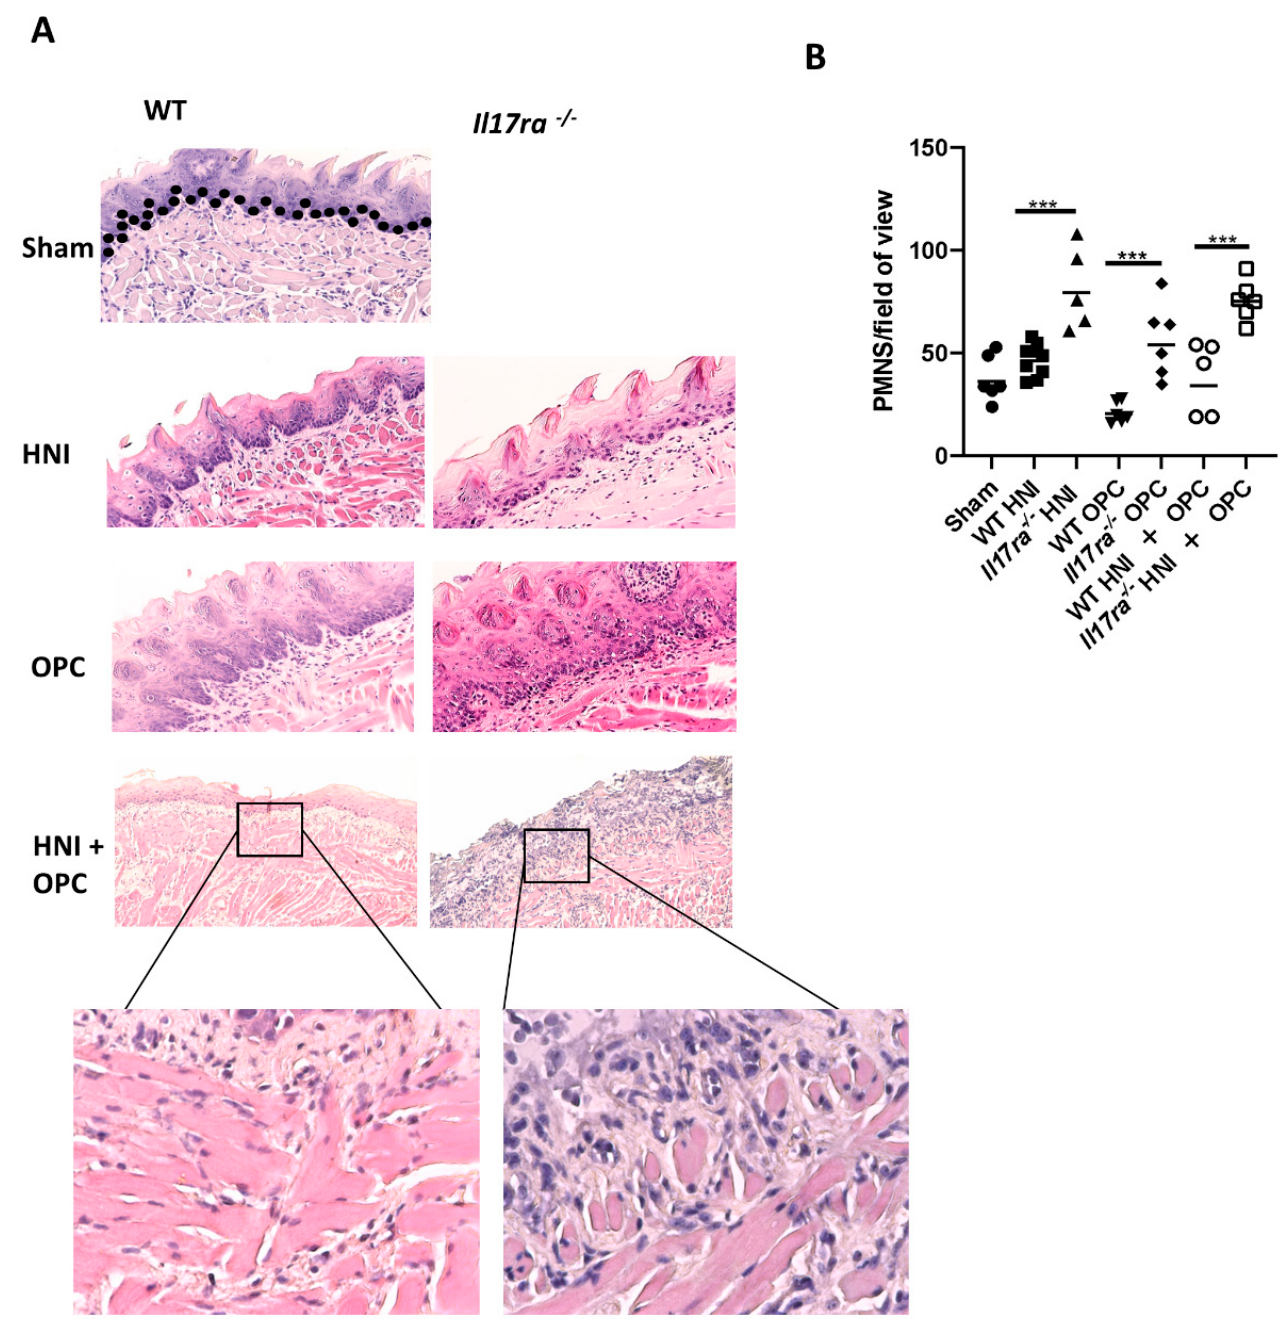
Figure 6. Increased neutrophil influx into tissue damaged by irradiation in the absence of IL-17RA. ( A ) Staining by hematoxylin and eosin of sectioned tongues and quantification of neutrophils on day 4 (n = 3–6 mice per group). Top Images taken at 20 × magnification, inset images taken at 40 × magnification. ( B ) Neutrophil quantification analyzed by one-way ANOVA with Tukey’s post hoc. Evaluators blinded to the treatment group and mouse cohort analyzed the tissue sections. (*** p < 0.001) Data represent 3 experimental repeats.